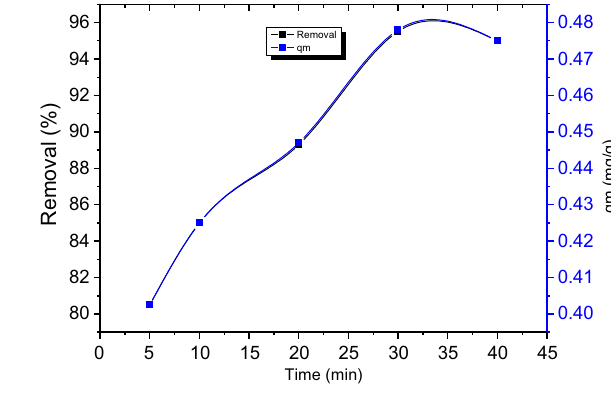
Fig. 6 Effect of adsorbent dose (g)